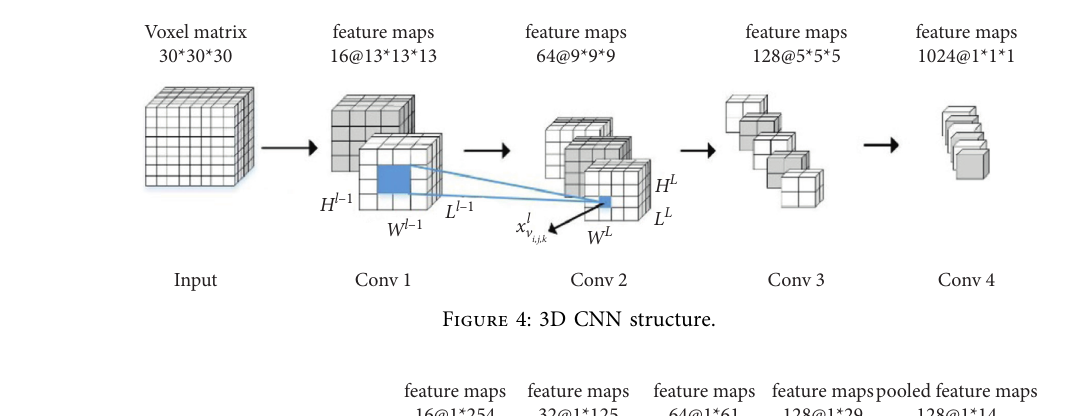
Figure 3: 3D model classification framework.